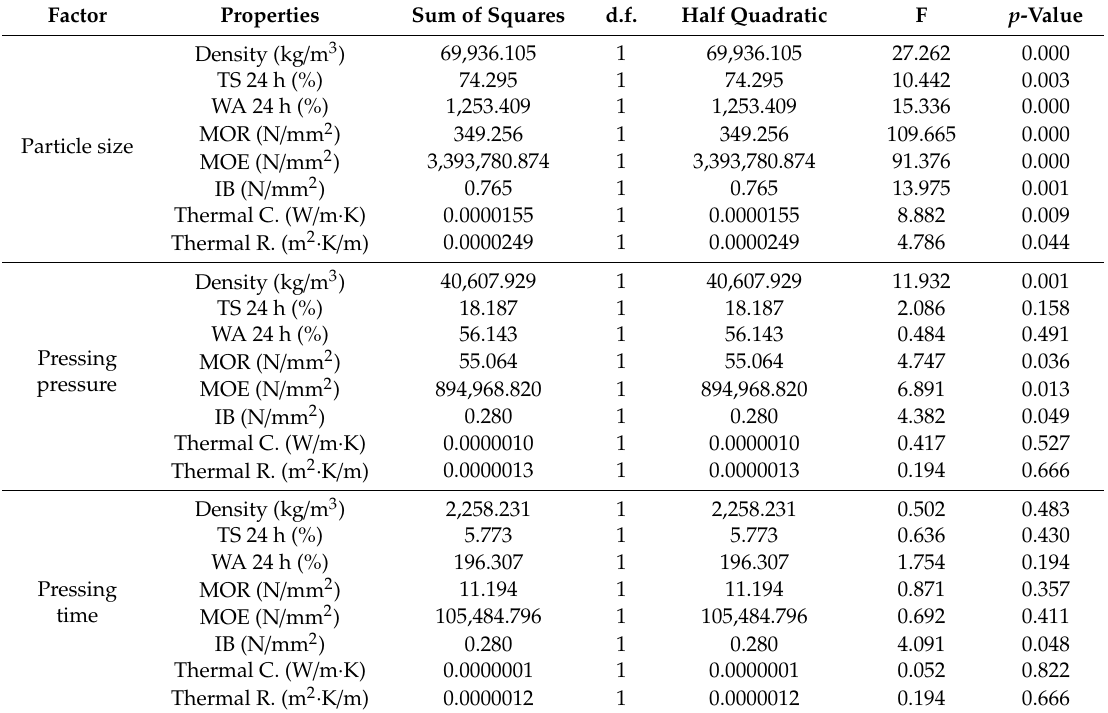
Table 3. ANOVA of the results of the tests.